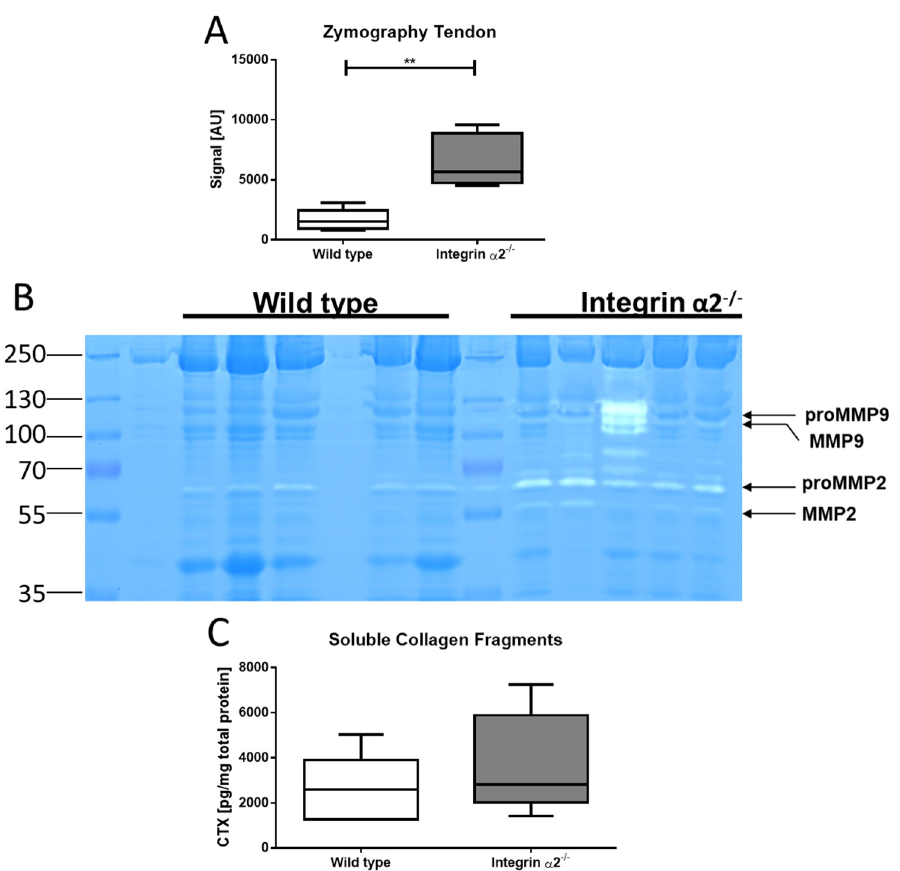
Figure 5. Resident MMP-2 activity is increased in integrin α 2 β 1-deficient tendons. Gelatin zymography of 30- µ g tendon lysate. Quantification of the MMP-2-activity signal ( A ). Zymography gel 10% acrylamide with polymerized gelatin. The arrows depict the pro and active forms of MMP-9 and MMP-2, respectively( B ).C-terminalfragments(CTX)ELISAquantificationofsolublecollagenfragments in the tendon ( C ) (N = 5). Mann-Whitney U test was used for statistical testing (** p <